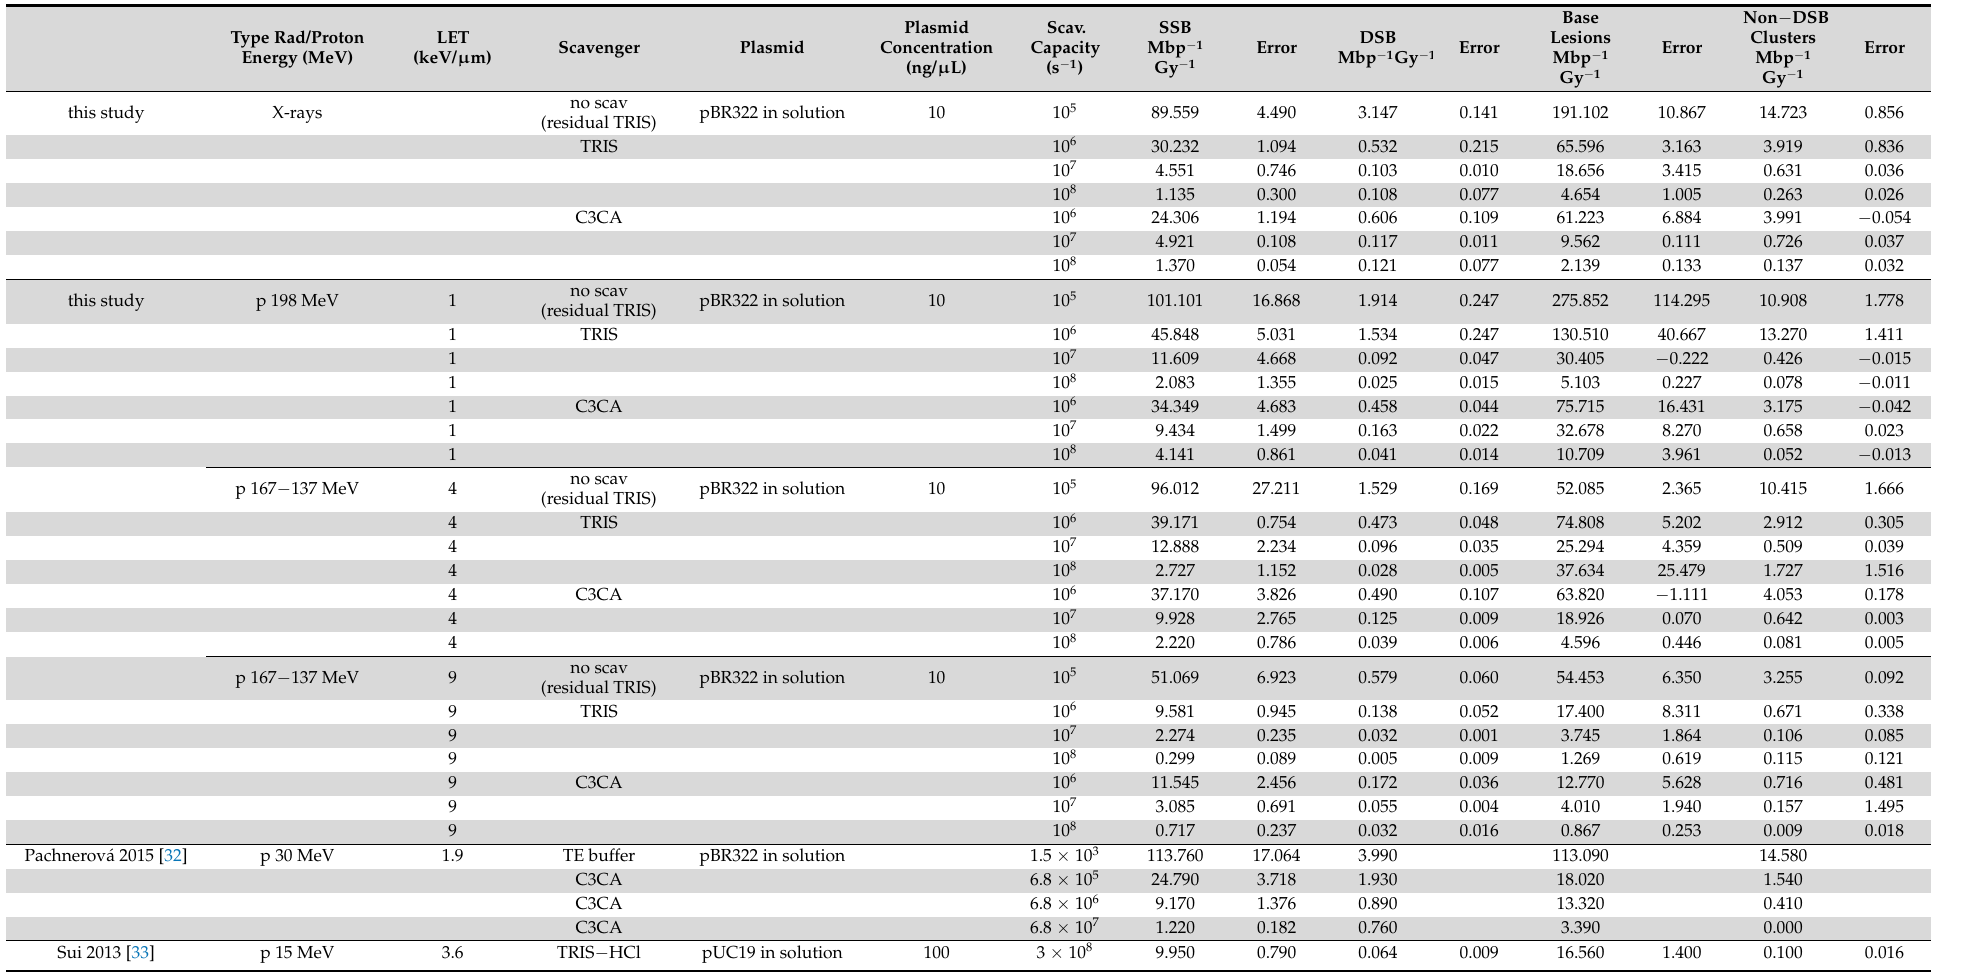
Table 1. IR (protons, ions and electromagnetic radiation) damage induction rate on plasmid systems: results from the present study and reported in the